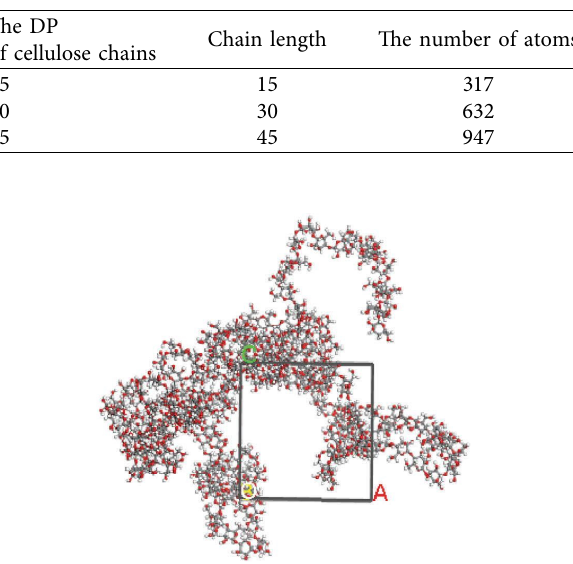
Table 1: Detailed information about the degree of polymerization of 15, 30, and 45.